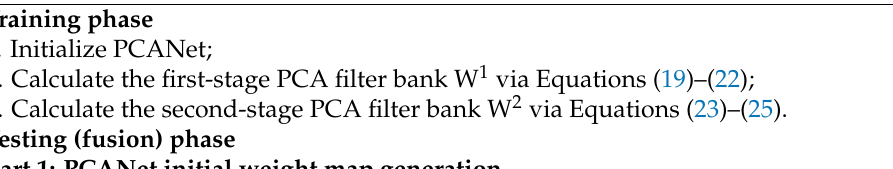
Algorithm 1 The proposed IR and visible image fusion